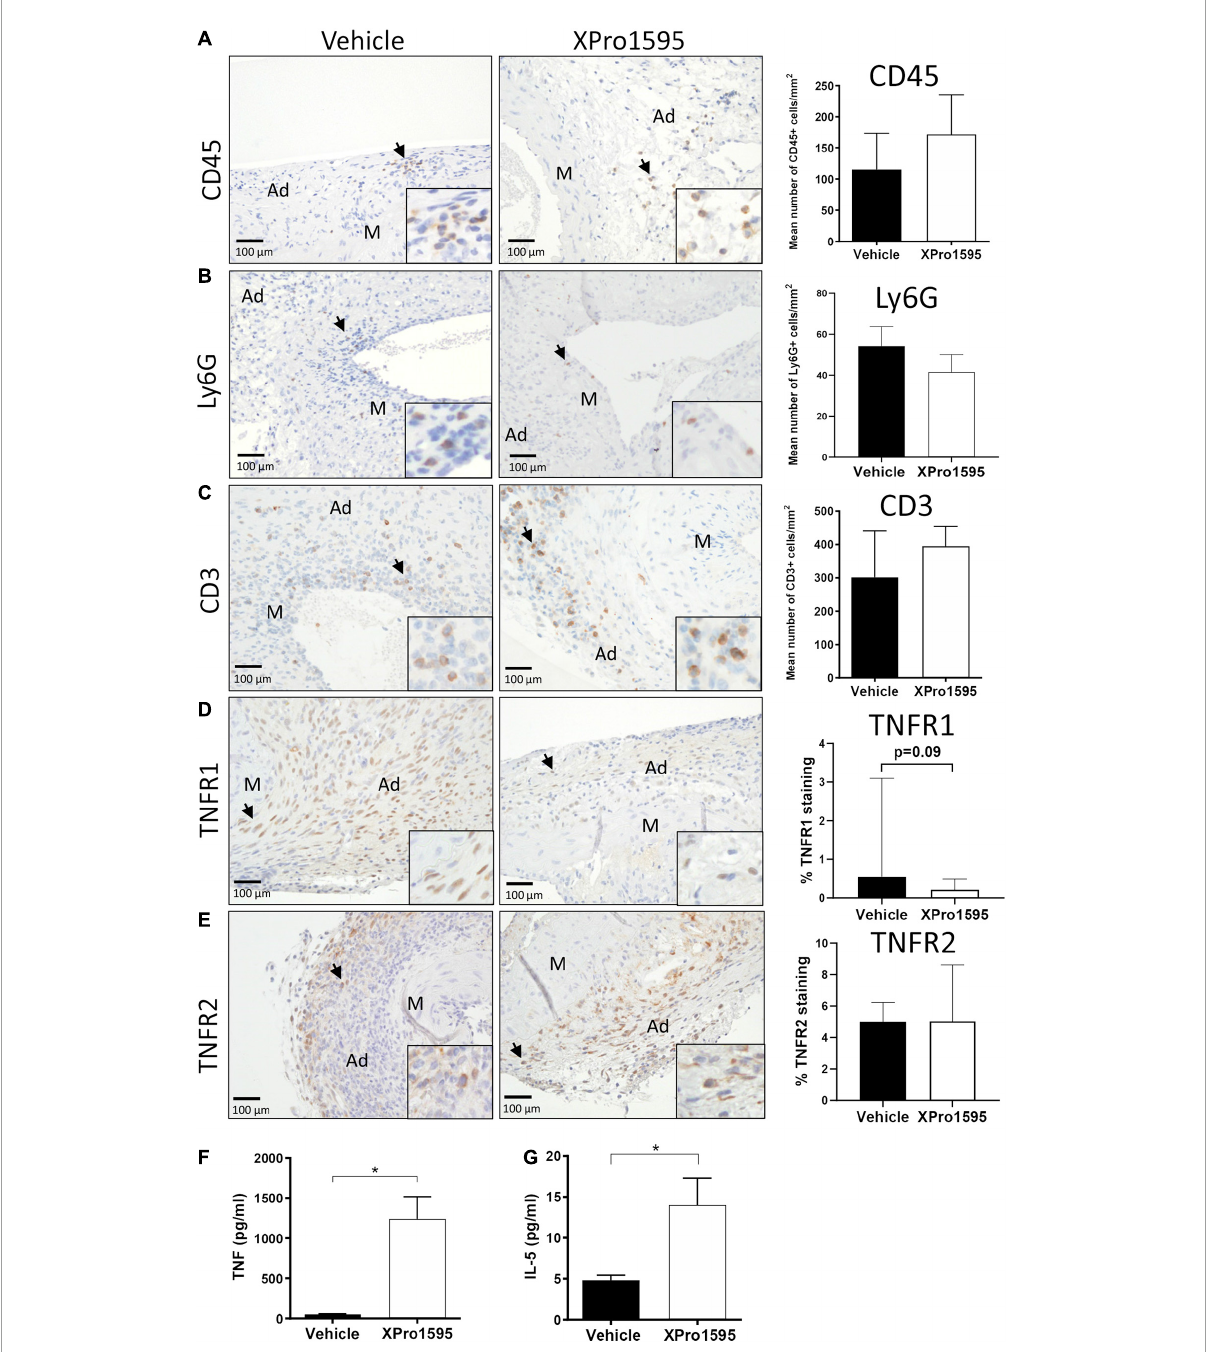
FIGURE7 Characterization of aneurysm wall composition after inhibition of solTNF in ANGII-induced abdominal aortic aneurysms. Representative micrographs of CD45-positive leukocytes (A) , Ly6G-positive neutrophils (B) , CD3-positive T cells (C) ( n = 13), TNFR1 localization (D) , TNFR2 localization (E) ( n = 6) and their respective semi-quantification (number of positive cells/mm 2 or % positive staining) in cross-sections of ANGII-induced AAA treated with vehicle or XPro1595 (2 mg/kg). Black arrows point to examples of positive stained cells. Circulating TNF plasma levels ( n = 4–5) (F) and IL-5 ( n = 6–7) (G) in ANGII-induced AAA treated with vehicle or XPro1595. Data are shown as mean SEM if data passed the D’Agostino and Pearson omnibus normality tests (B,C,E–G) . *Denotes p < 0.05 analyzed by unpaired Student’s t -test for normally distributed data, otherwise by Mann-Whitney test represented as median with interquartile range (A,D) . M, media; Ad,